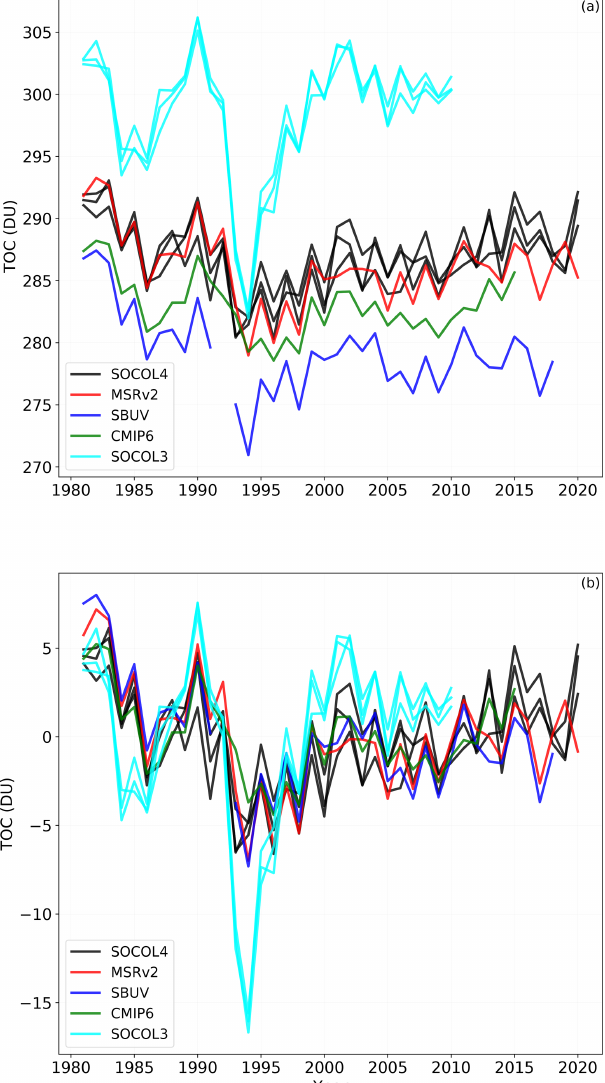
Figure 16. (a) Near-global (55 ◦ S–55 ◦ N) mean ozone evolution simulated with SOCOLv4 (black), MSR2 (red), SBUV (dark blue), SOCOLv3 (light blue), and CMIP6 (green). (b) The same but anomalies with respect to the mean over the whole